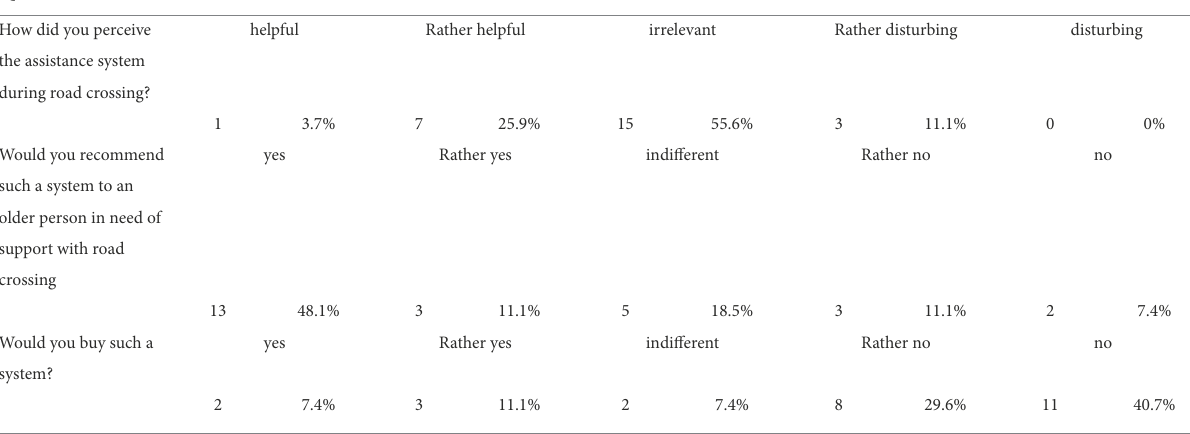
TABLE 2 Frequencies and percentages of answers to the three acceptance questions regarding the assistance system in the field study.